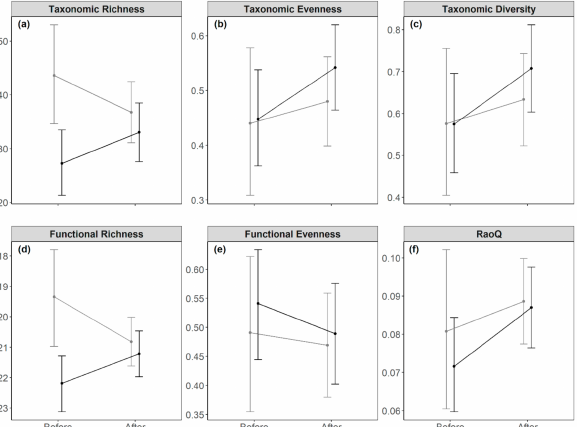
Figure 5. Linear model outputs (mean and 95% confidence intervals) indicating the effects of restora- tion on taxonomic ( a – c ) and functional ( d – f ) metrics. Control = grey; restored = black. ( a ) Taxonomic richness, ( b ) taxonomic evenness, ( c ) taxonomic diversity, ( d ) functional richness, ( e ) functional evenness and ( f )